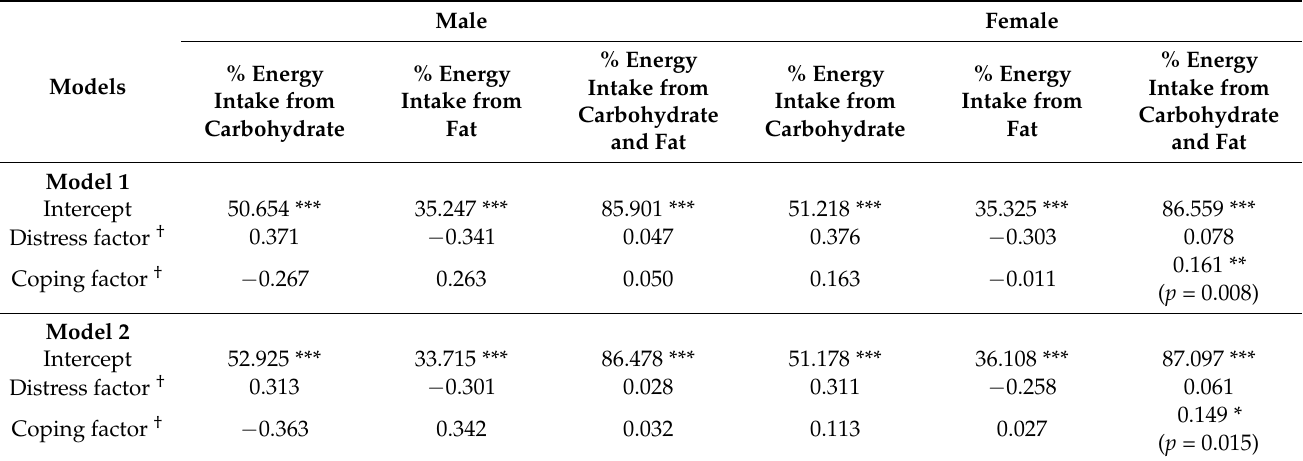
Table 3. The effects of distress and coping factors on percentage of energy from carbohydrate and fat by